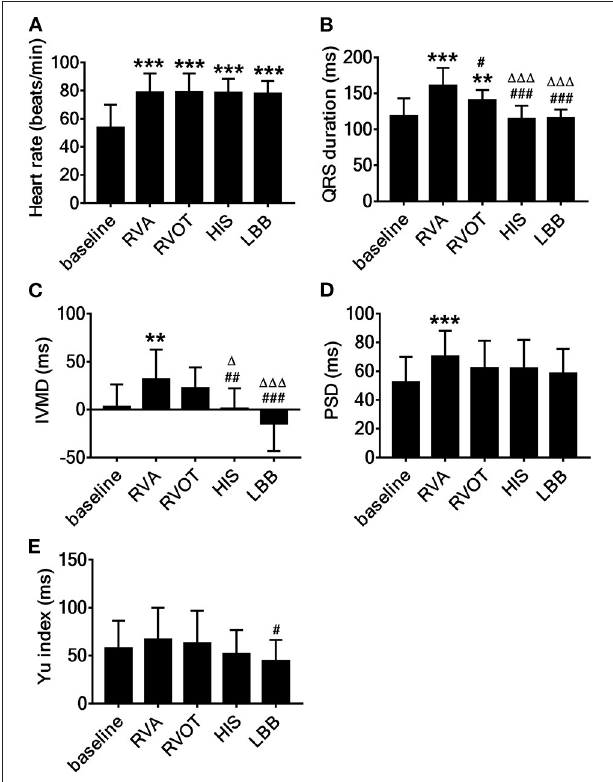
FIGURE 4 | Acute effect on cardiac synchrony associated with pacing at the different sites. (A) Heart rates, (B) QRS duration, (C) IVMD, interventricular mechanical delay, (D) PSD, the standard deviation of time to longitudinal peak strain of 17 segments, (E) Yu index, the standard deviation of time from QRS to peak systolic velocity in ejection phase for 12 left ventricular segments. ** P < 0.01, *** P < 0.001 vs. baseline, # P < 0.05, ## P < 0.01, ### P < 0.001 vs. right ventricular apex (RVA), 1 P < 0.05, 111 P < 0.001 vs. right ventricular outflow tract